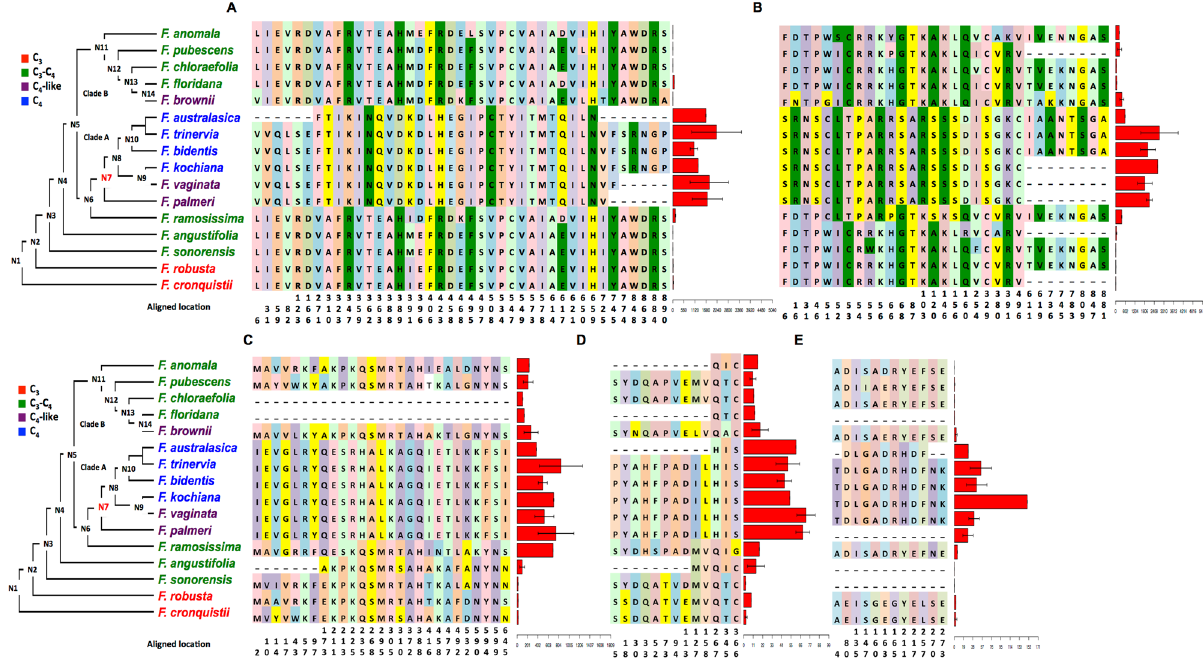
Figure 2. Modifications in genes in C 4 pathway in predicted protein sequences and transcript abundances mapped to the Flaveria phylogeny. The predicted amino acid changes and the transcript abundance (FPKM) of the genes encoding the enzymes in C 4 pathway are shown. Only the amino acid residues predicted to be different between C 3 and C 4 species are superimposed on the recent published phylogeny of Flaveria . The colors of amino acid residues have no meaning and are only for visualization purposes. Numbers below the amino acids indicate the location sites in the multiple sequence alignments. FPKM values with standard errors are shown to the right of the amino acid changes as red bars. ( A ) phospho enol pyruvate carboxylase (PEPC); ( B ) pyruvate orthophosphate dikinase (PPDK); ( C ) NADP-malic enzyme (NADP-ME); ( D ) pyruvate orthophosphate dikinase regulatory protein (PPDK-RP); ( E ) phospho enol pyruvate protein kinase A (PPCKA). Protein sequences from UniprotKP are: F. trinervia PEPC, P30694; F. bidentis PPDK, Q39735; F. brownii PPDK, Q39734; and F. trinervia PPDK, P22221. Sequence alignments are available in Additional file